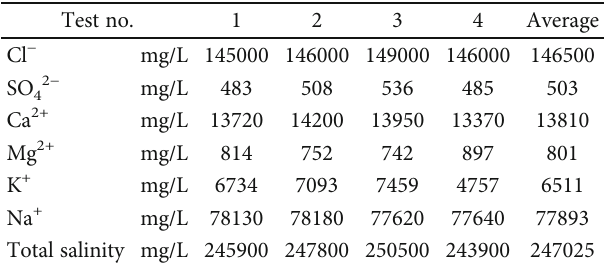
Table 2: Formation water salinity test results (Tarim tight gas formation).